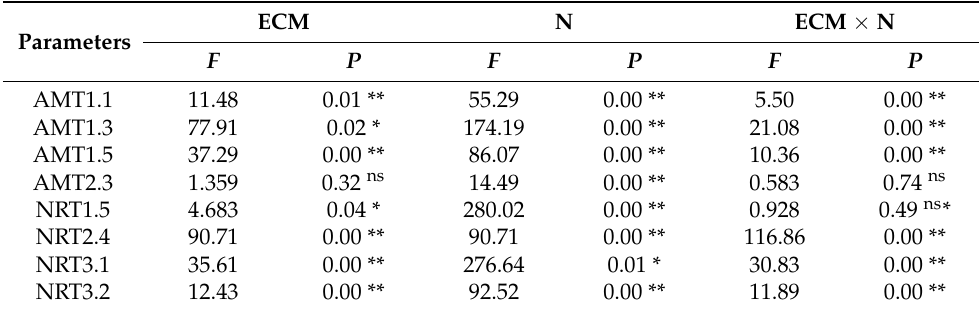
Figure 5. Correlation coefficients between the expression levels of AMT family genes and NRT family genes of Pinus massoniana seedlings. Note: Pearson correlation coefficients r were determined across all nitrogen treatments and inoculation treatments. * p < 0.01 (Bonferroni correction). Table 6. Effects of ECM treatment (ECM), nitrogen treatment (N), and N × ECM on the parameters of Pinus massoniana seedlings.